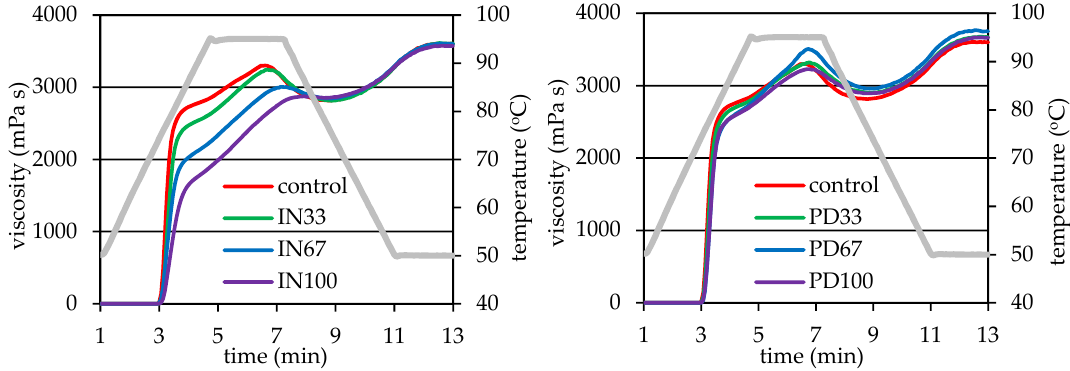
Figure 1. Pasting curves of potato starch in systems forming starch-milk desserts: without steviol glycosides (control), with inulin (IN33, IN67, IN100), with polydextrose (PD33, PD67, PD100). Table 2. Parameters of pasting characteristics of potato starch in systems forming starch-milk desserts. Sample